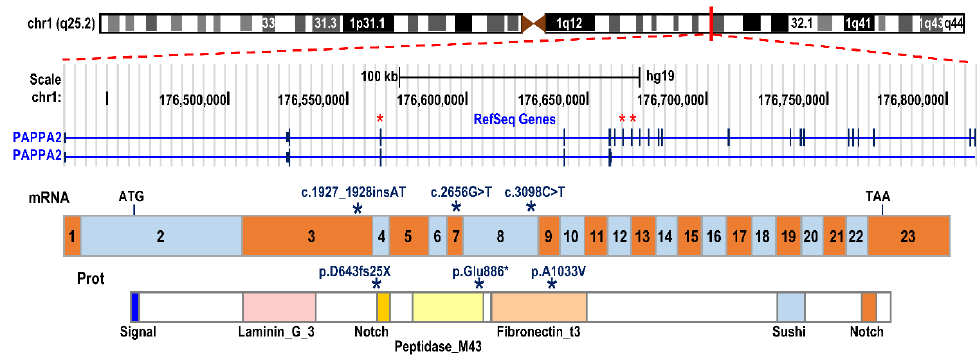
Figure 3. PAPPA2 gene mutations described to date. Schematic representation of the genomic structure of the PAPPA2 gene on chromosome band 1q24, the encoded mRNA and the protein with its relevant functional domains. The stars indicate the location in the exons, mRNA and protein where the subjects’ mutations are found.